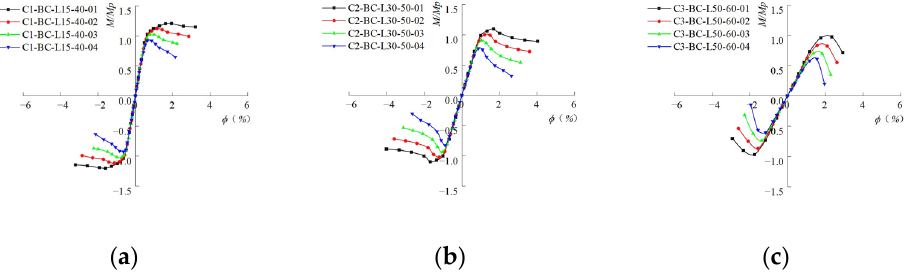
Figure 11. The effect of axial compression ratio. ( a ) λ = 15, h/t =40; ( b ) λ = 30, h/t =50; ( c ) λ = 50, h/t = 60.